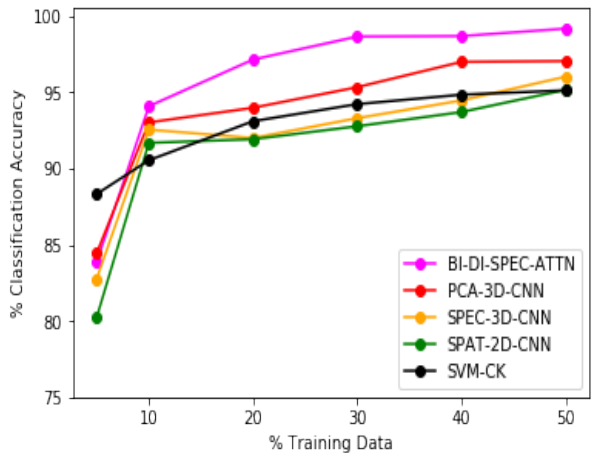
Figure 6. Overall classification accuracies on Indian Pines dataset for varying sizes of training samples.